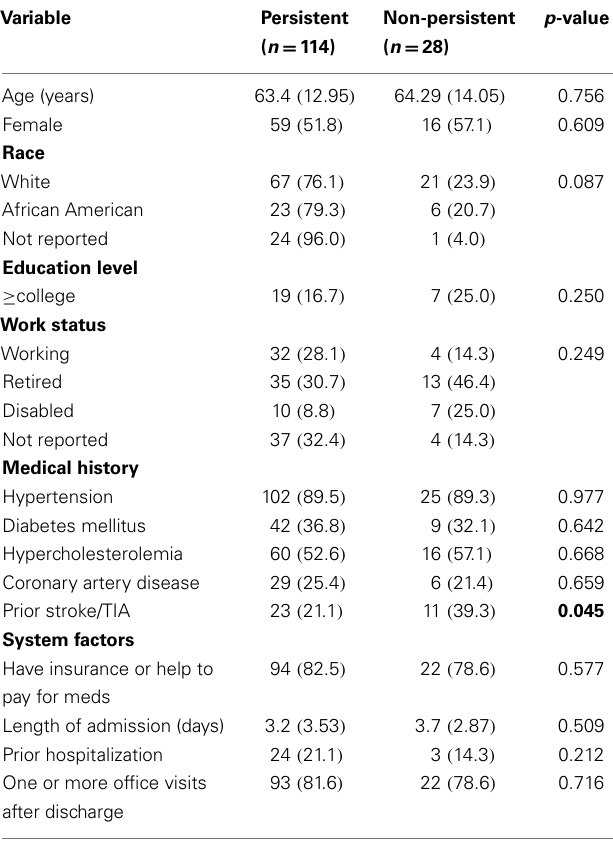
Table 2 | Factors associated with medication persistence inTRACS